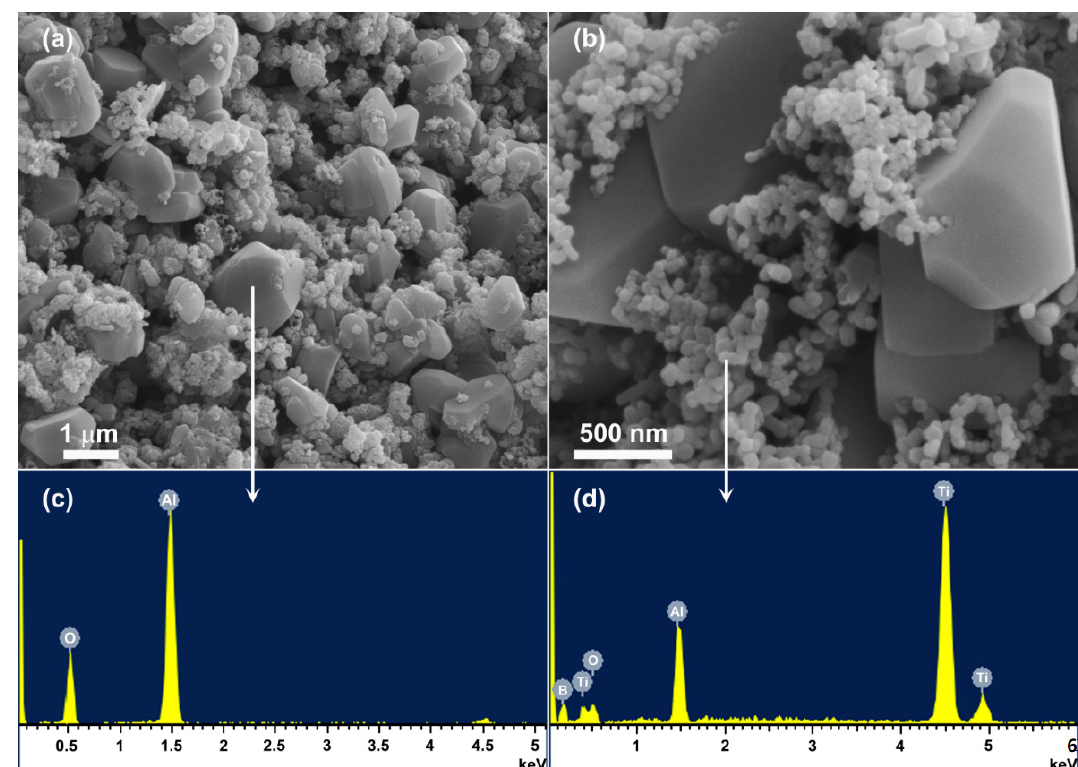
Figure 8. SEM images ( a , b ) and corresponding EDS ( c , d ) of the Al 2 O 3 -TiB 2 composite powder resultant from 4 h firing in NaCl at 1150 °C.